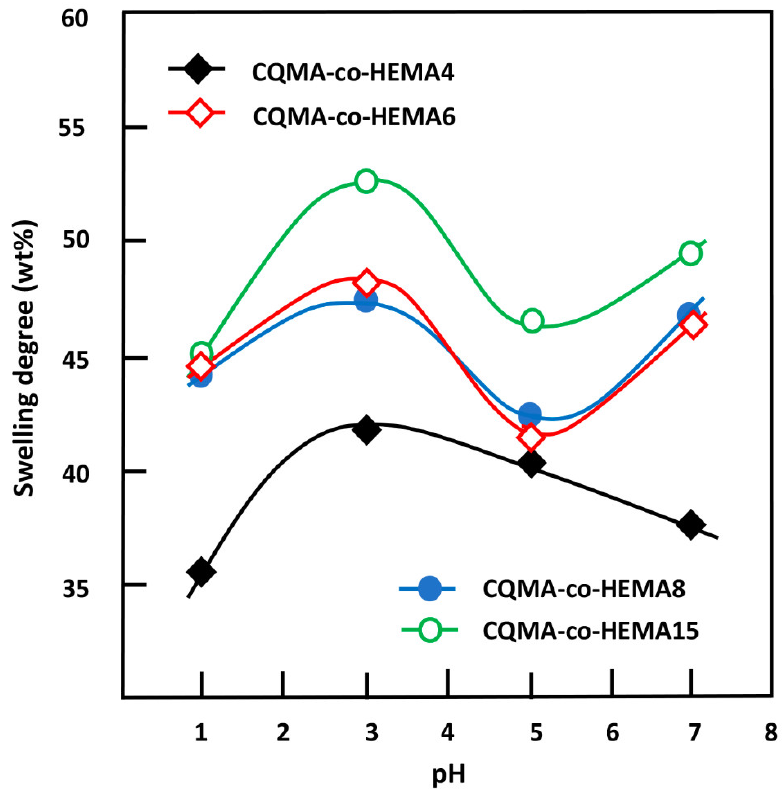
Figure 11. Variation of the swelling degree at equilibrium of CQMA- co -HEMA systems versus the media pH.